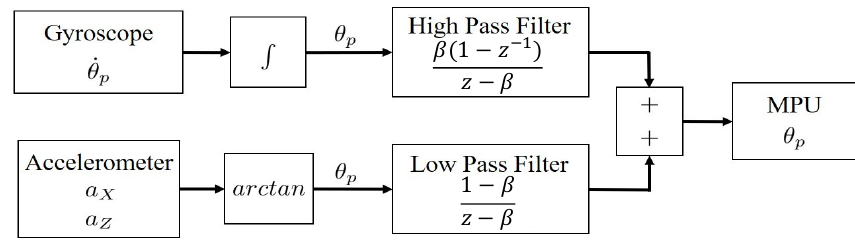
Figure 5. The complementary